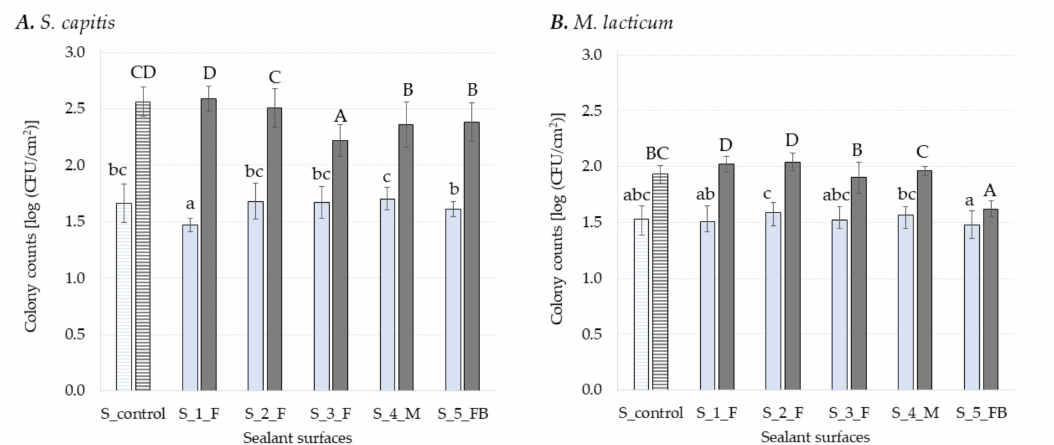
Figure 1. Log CFU cm − 2 of S. capitis ( A ) and M. lacticum ( B ) enumerated on different sealant surfaces after 3 h (light blue) and 48 h (dark grey) of incubation. Surfaces with antimicrobial coatings are colored with a solid fill and surfaces without antimicrobials are highlighted with a pattern fill. Different lowercase letters denote significant differences (multiple range test, p ≤ 0.05) between the respective samples during adhesion (3 h), while uppercase letters indicate differences in early-stage biofilm formation (48 h). Each experiment was repeated in at least in triplicates.